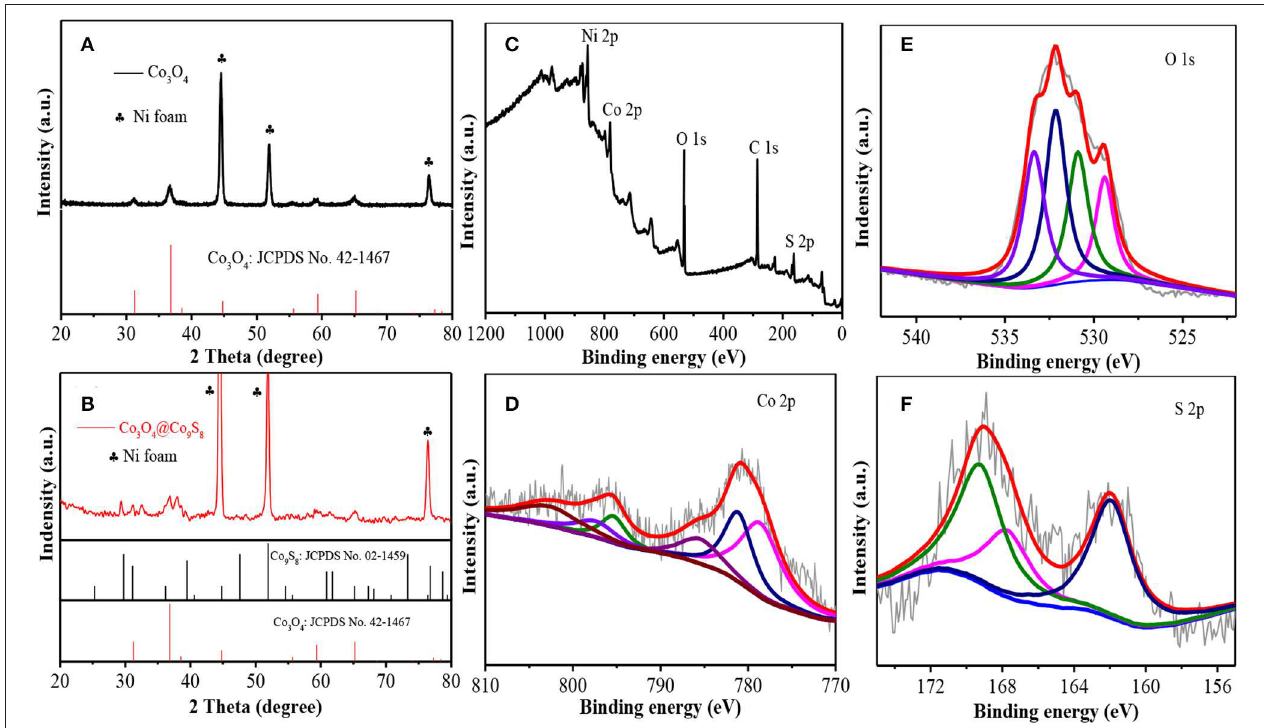
FIGURE 1 | (A) XRD patterns of Co-NWs, (B) XRD patterns of Co-HSs, (C) full spectrum, (D) S 2p, (E) O1s, and (F) Co 2p.